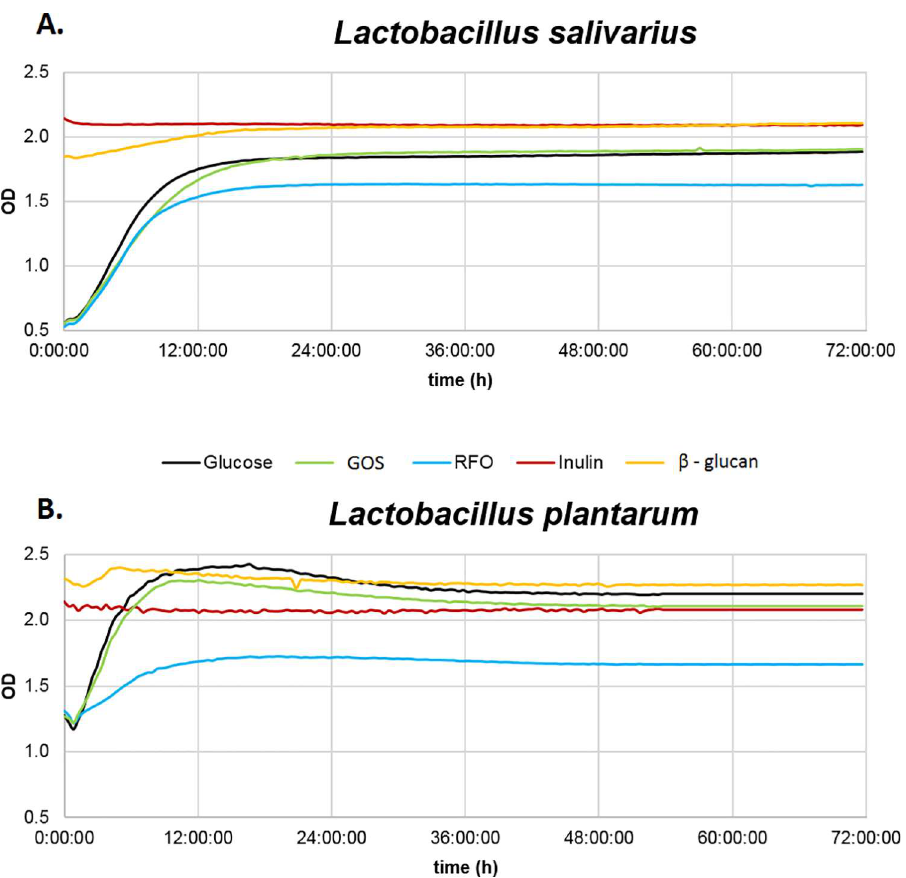
Fig 1. Changes in optical density (OD) of culture media during incubation of Lactobacillus bacteria with prebiotics. Incubationwas performed with glucoseas a control for (A) Lactobacillus salivarius and (B) Lactobacillus plantarum in presenceof prebioticsRFO, Inulin, GOS, or beta-glucan. Growth of bacteriain the MRS medium supplemented with the prebiotics glucose,GOS, RFO, inulin, or beta-glucan was measured using the automatedgrowth analyzerBioscreen C (Oy Growth Curves Ab, Ltd.) for 72